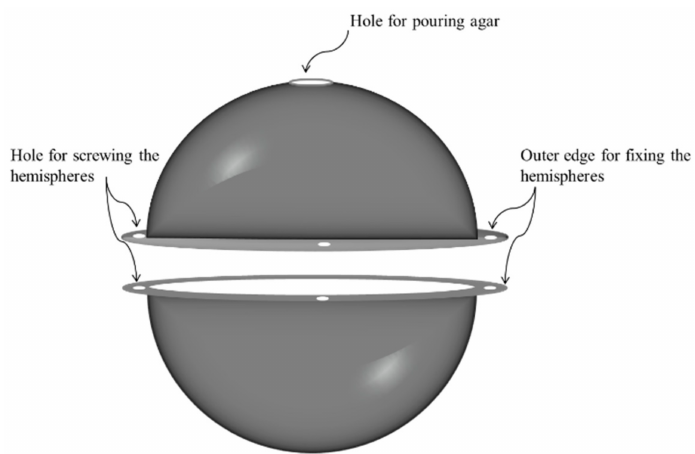
Figure 1. Mold for making the spherical phantom.